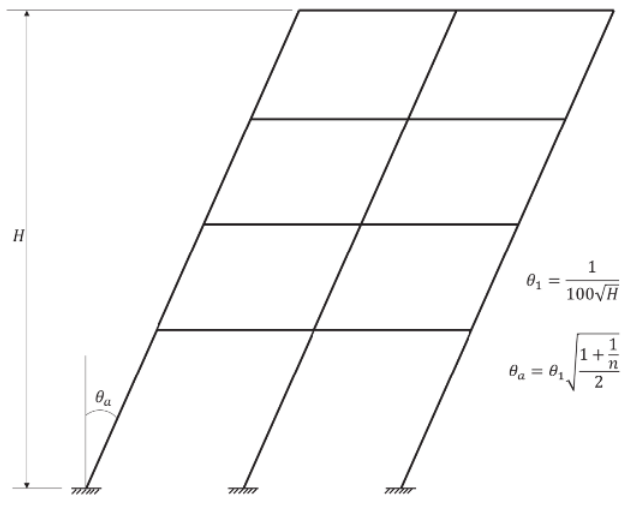
Desaprumo global dos elementos verticais